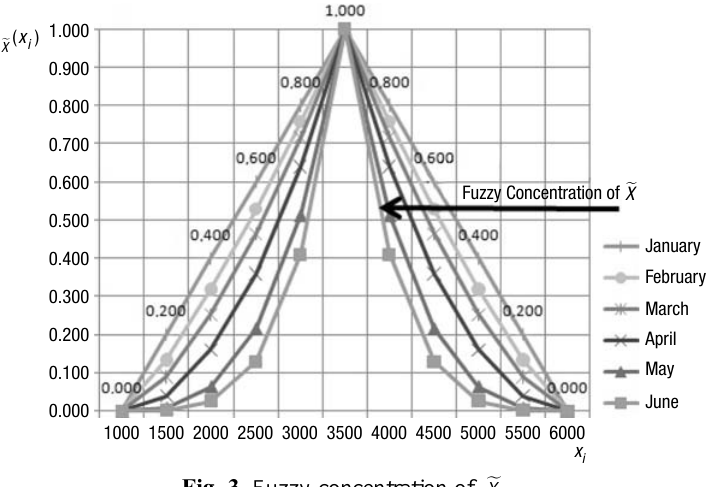
Fig. 3. Fuzzy concentration of 